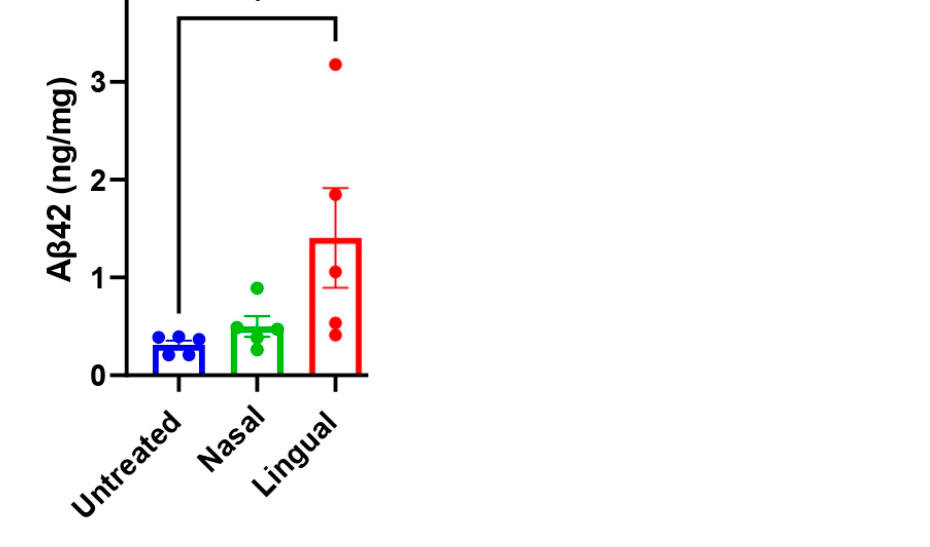
Figure 3. Assessment of brain PBS ‐ insoluble A β 42 levels in experimental Tg2576 mice by ELISA. The formic acid ‐ soluble fraction was biochemically assessed to determine the insoluble A β 42 concentra ‐ tion in experimental and untreated animals as explained in Materials and Methods. Values are ex ‐ pressed as mean ± SD. Statistical analyses were performed using One ‐ way ANOVA and Tukey test (* p <